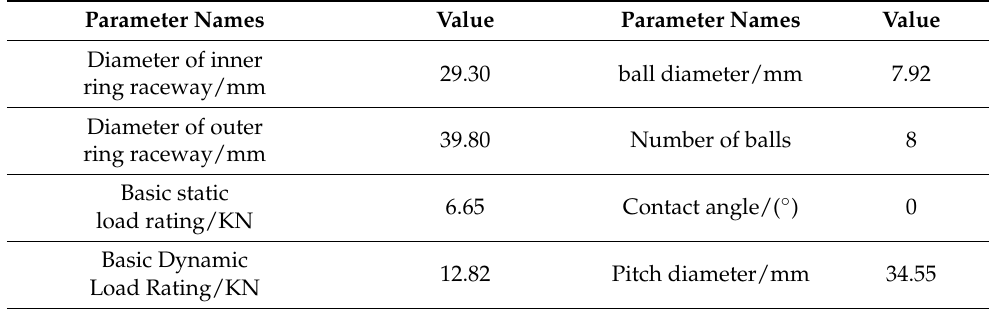
Table 4. LDK UER 204 rolling bearing